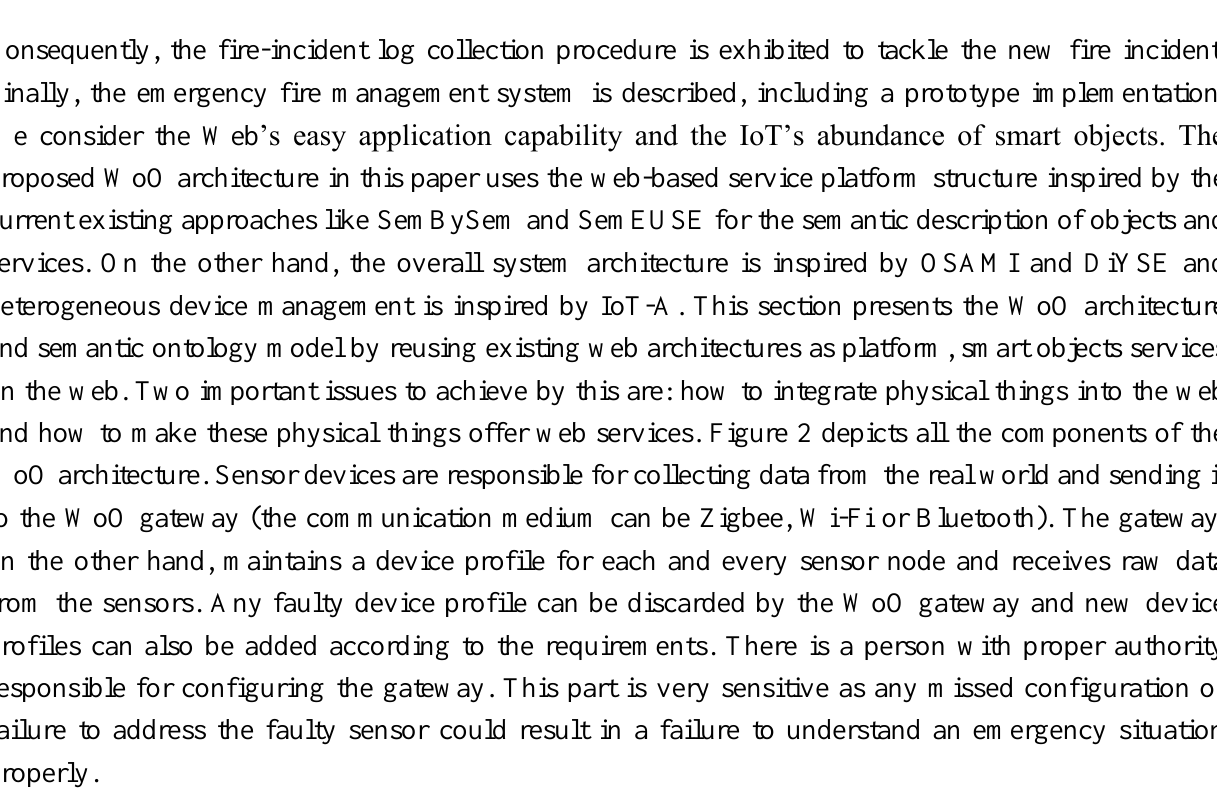
Figure 2. Web of Objects (WoO) architecture for an emergency fire management